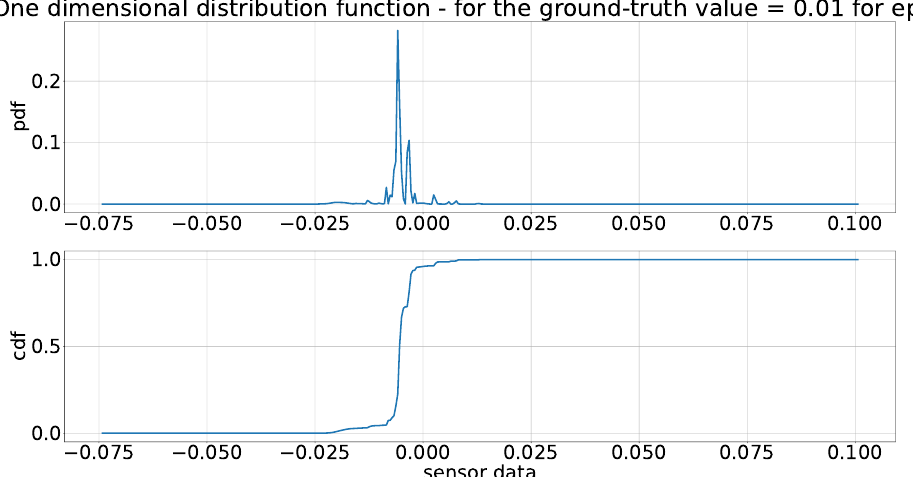
Figure 18. One-dimensional distribution functions of the inertia model for (cid:101) φ for a value of 0.01 (deg).